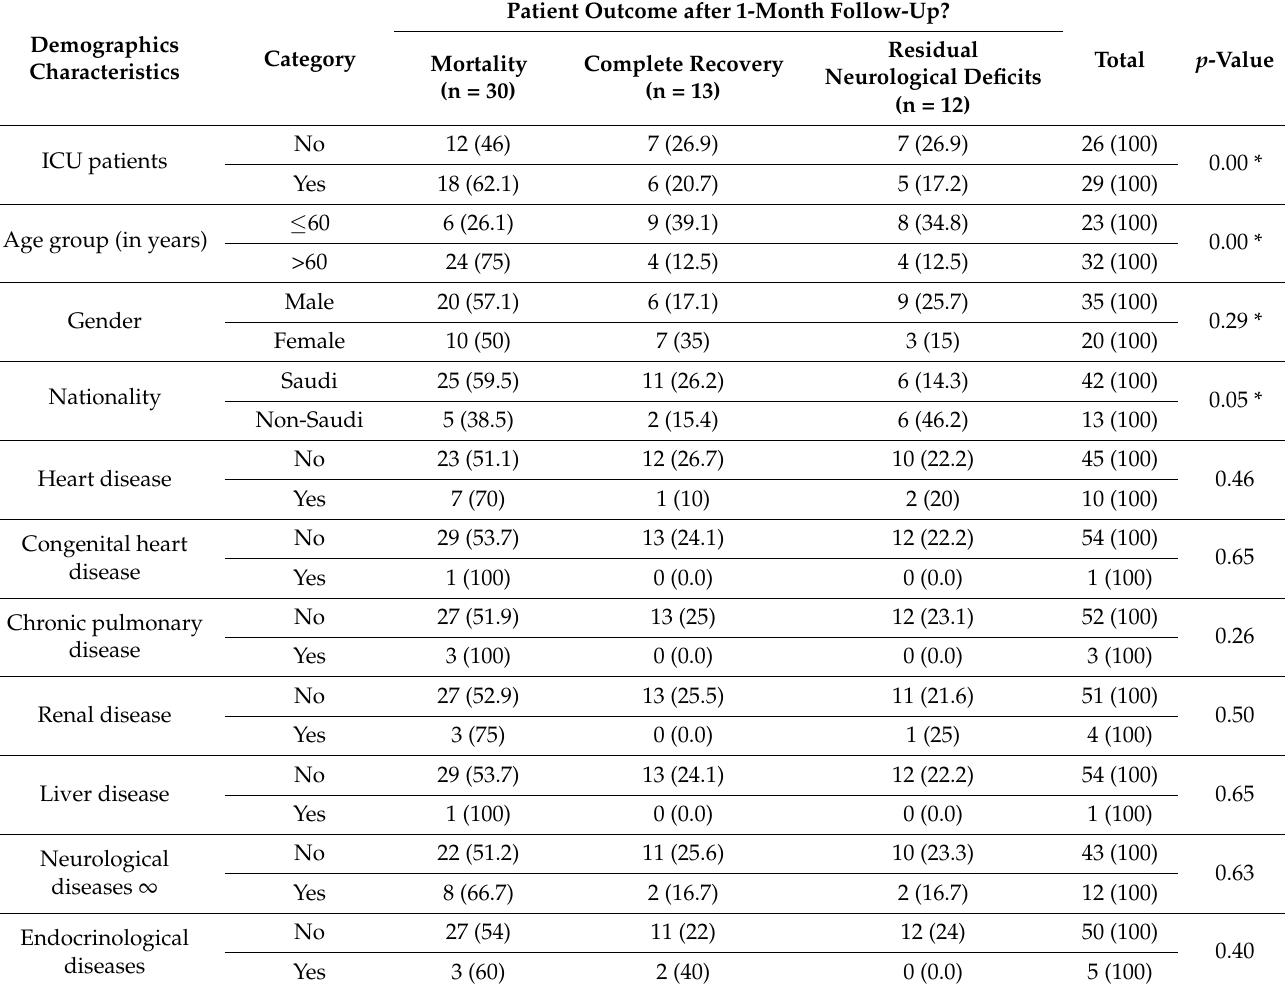
Table 1. Relation of patient’s outcome with demographic characteristics and co-morbid